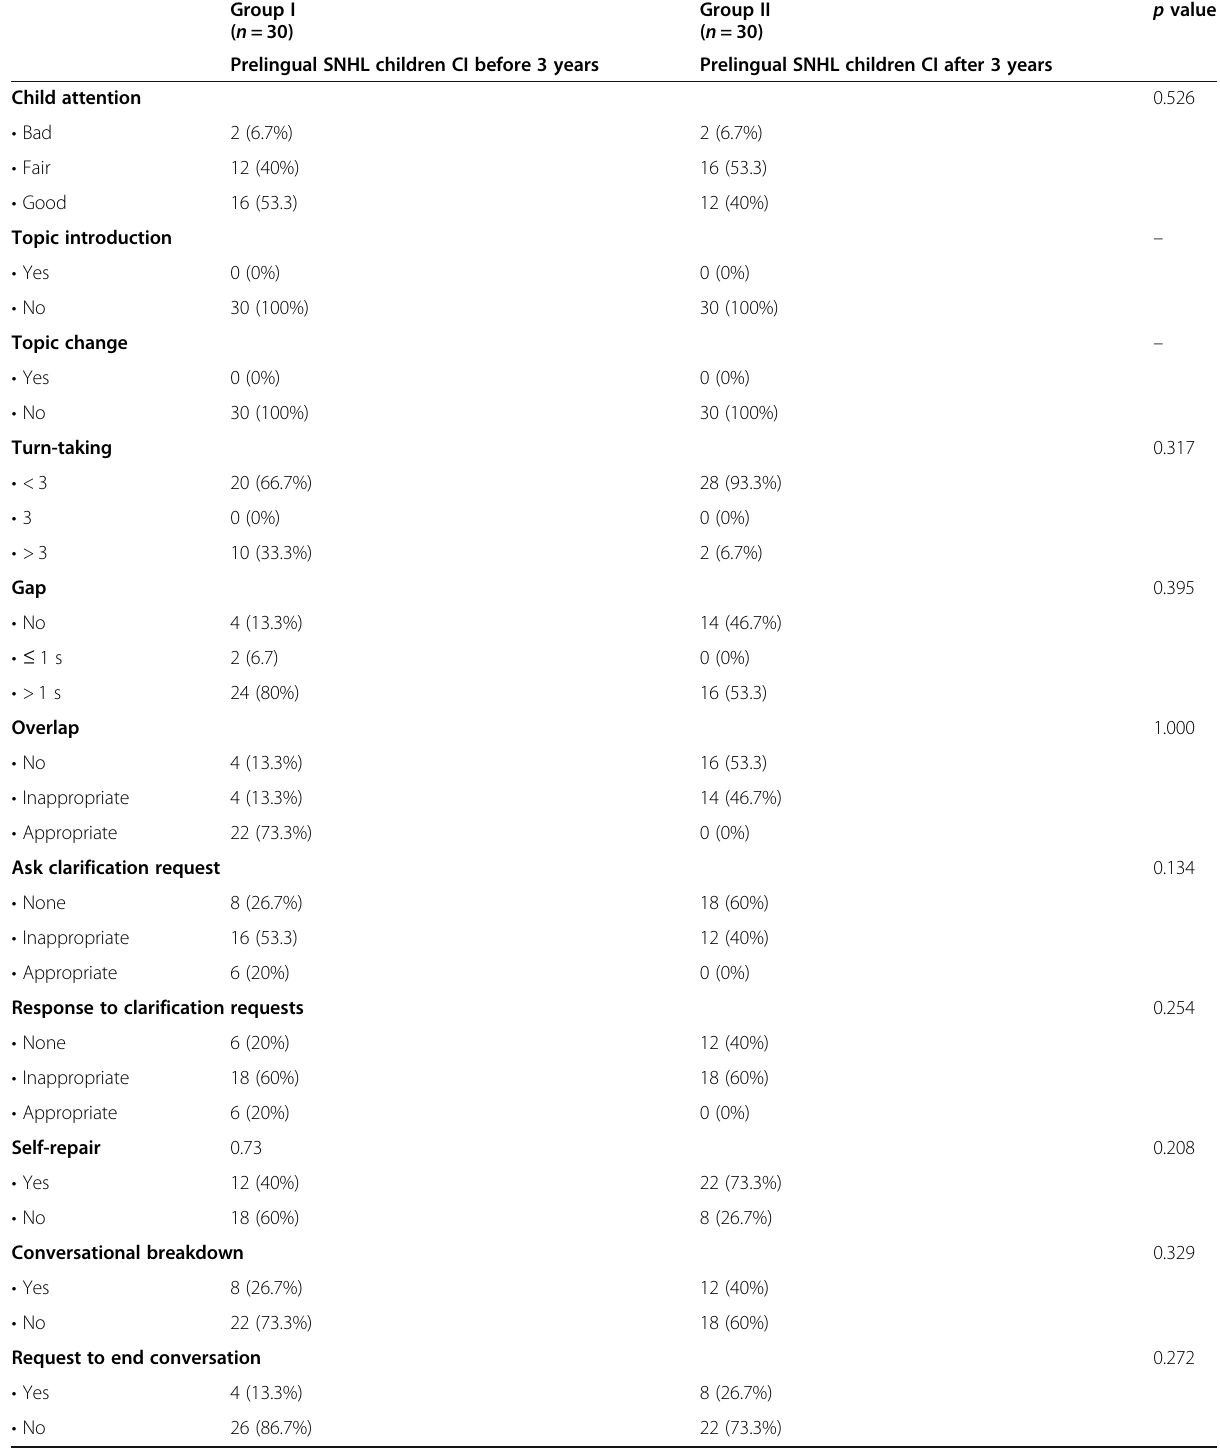
Table 6 Comparison of the Egyptian Arabic Pragmatic Language test (EAPLT) results in conversational skills between the 2 studied